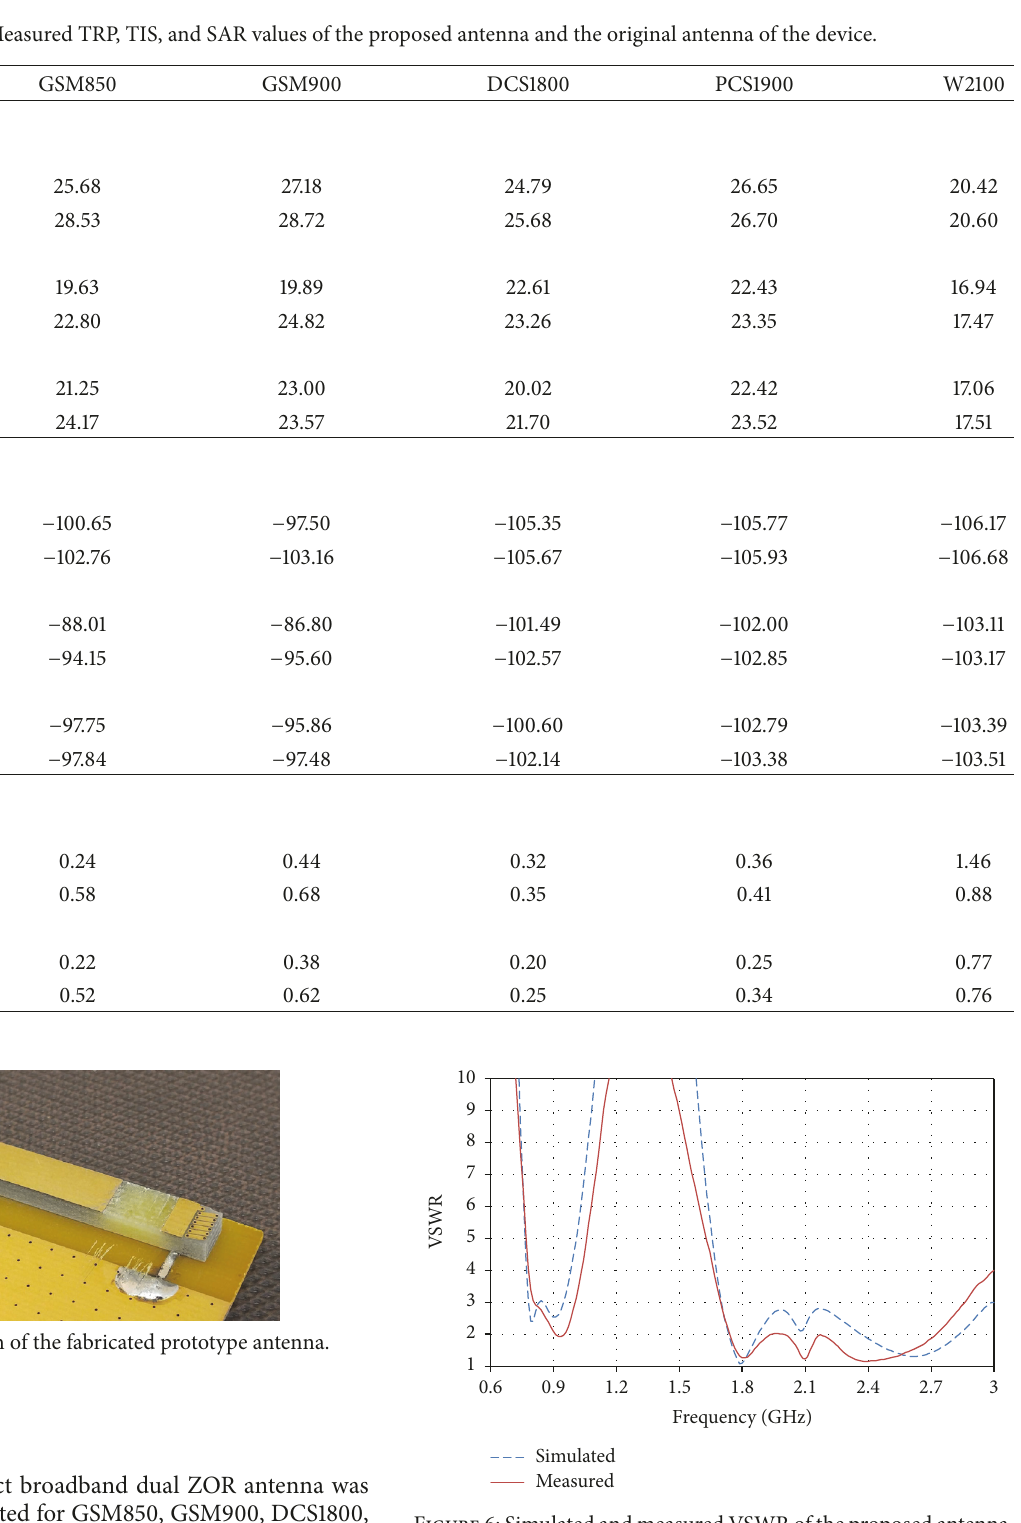
22.95% and 51.43%, respectively. The antenna provides omni- directional radiation patterns and measured radiation effi- ciencies exceeding 43.3% and 47.5% for low and high